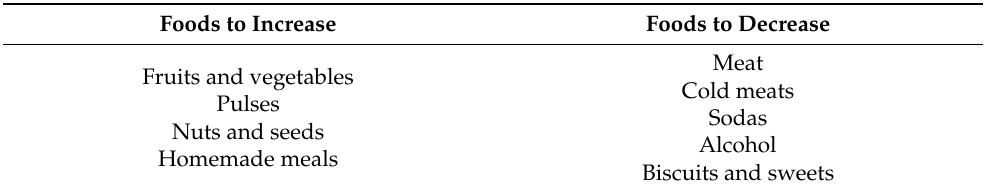
Meat Cold meats Sodas Alcohol Biscuits and sweets